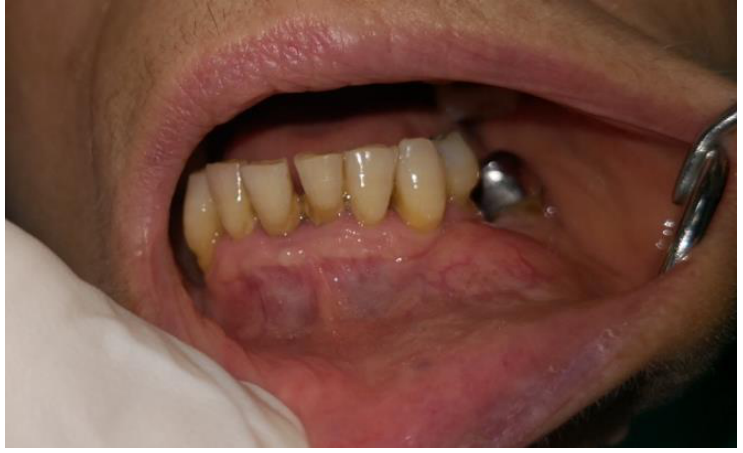
Figure 1. Intraoral osseous expansion.